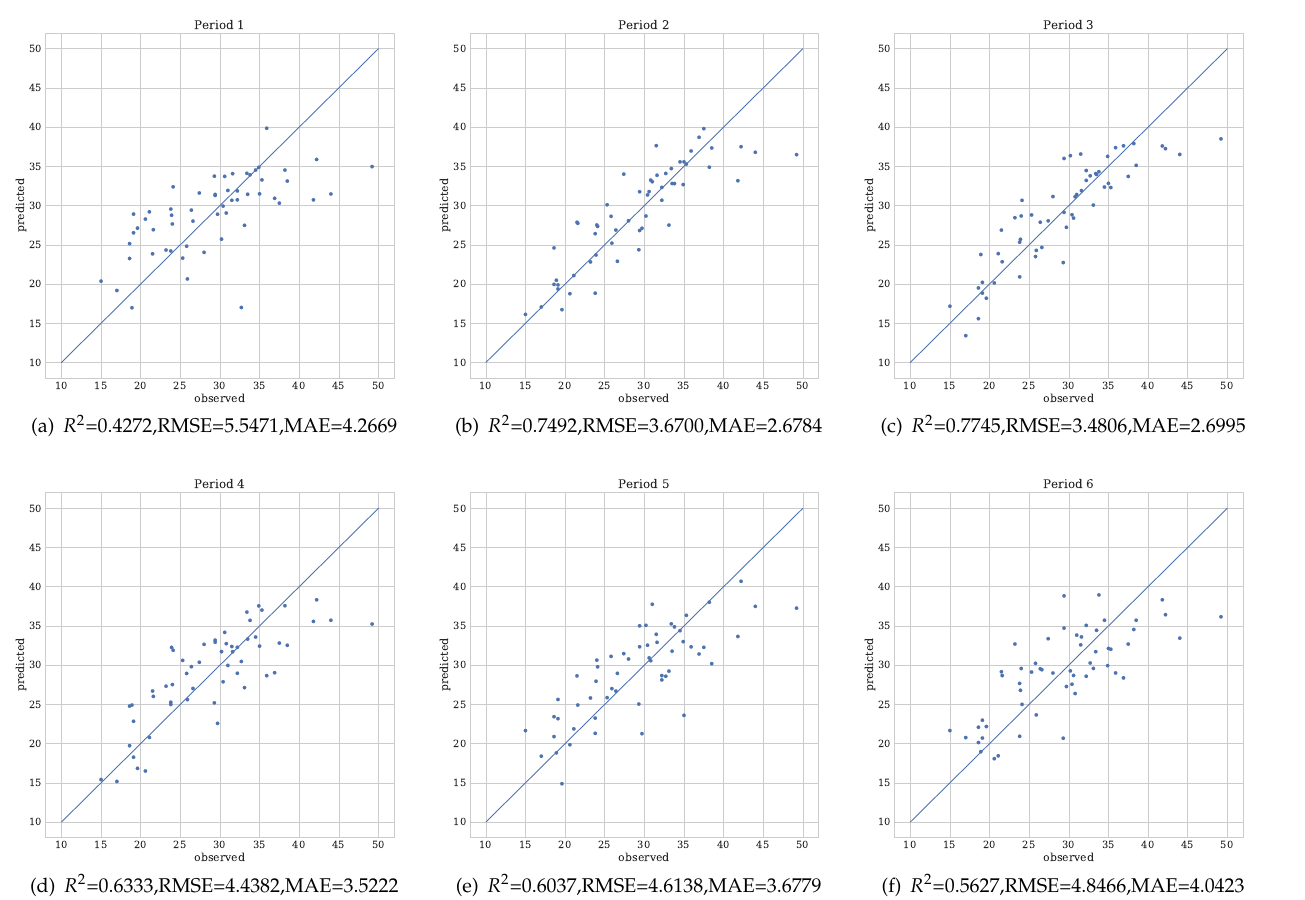
Figure 3. Scatter plots of observed versus predicted values fitted using the best predictors for the six